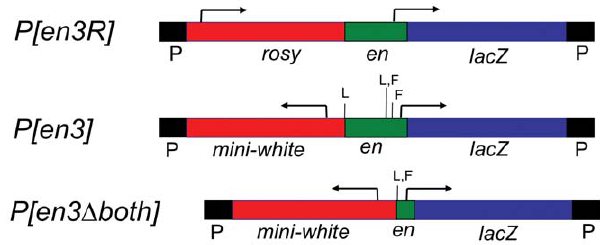
Figure 2. PREs silence mini- white expression in P[en3] - en eyes. Eyes of 5-day old male flies are shown. w; P[en3]-en/ + (left) and w; P[en3 D both]-en/ + (right).